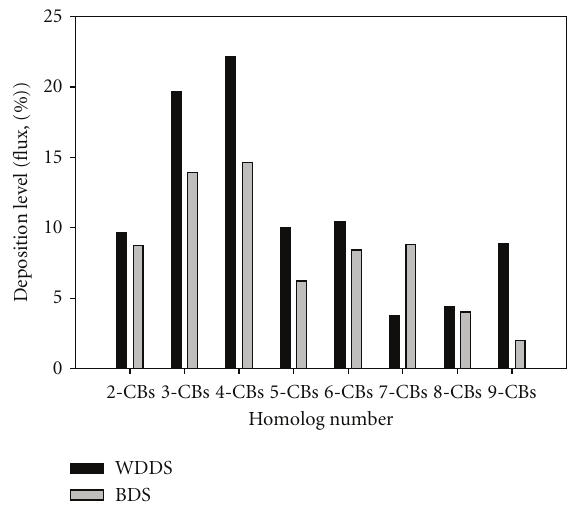
Figure 4: PCB homolog distribution of dry deposition flux